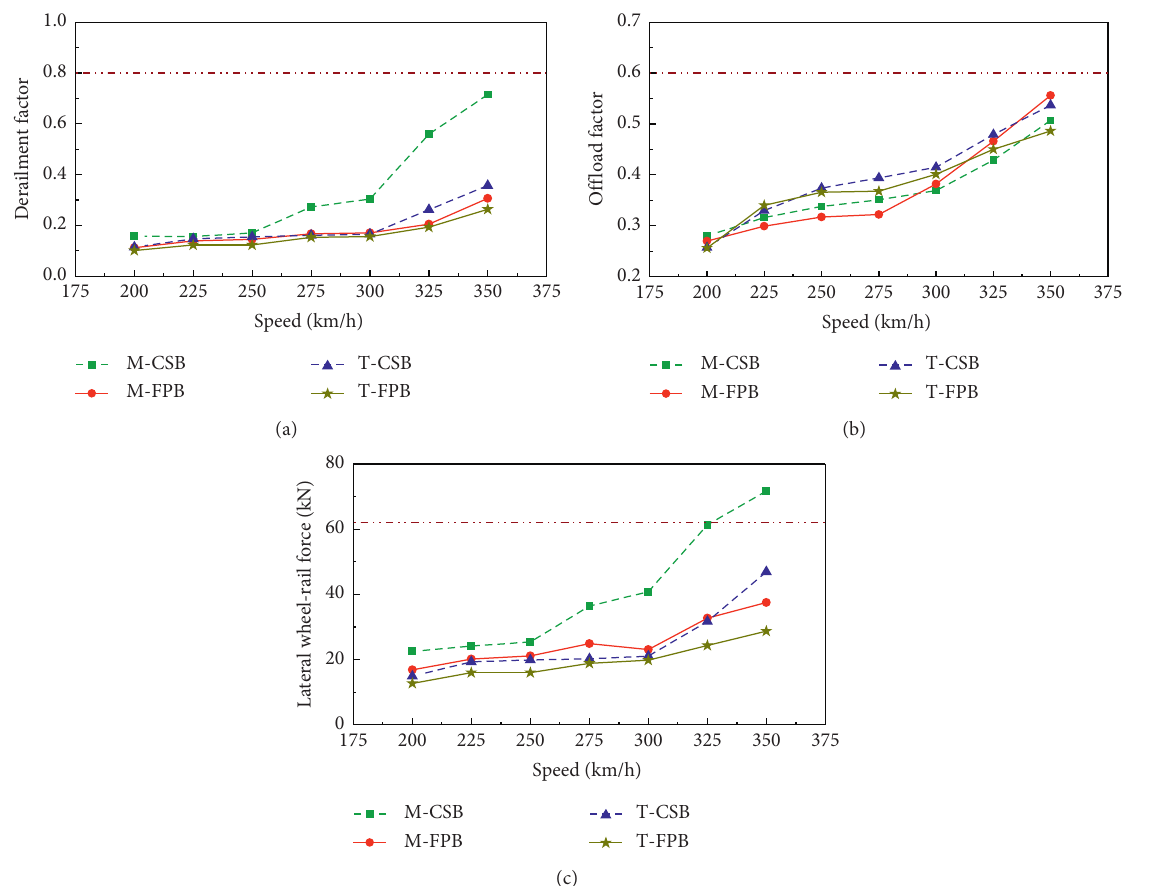
Figure 12: Distributions of running safety indices of the train versus train speed. (a) Derailment factor. (b) Offload factor. (c) Lateral wheel- rail